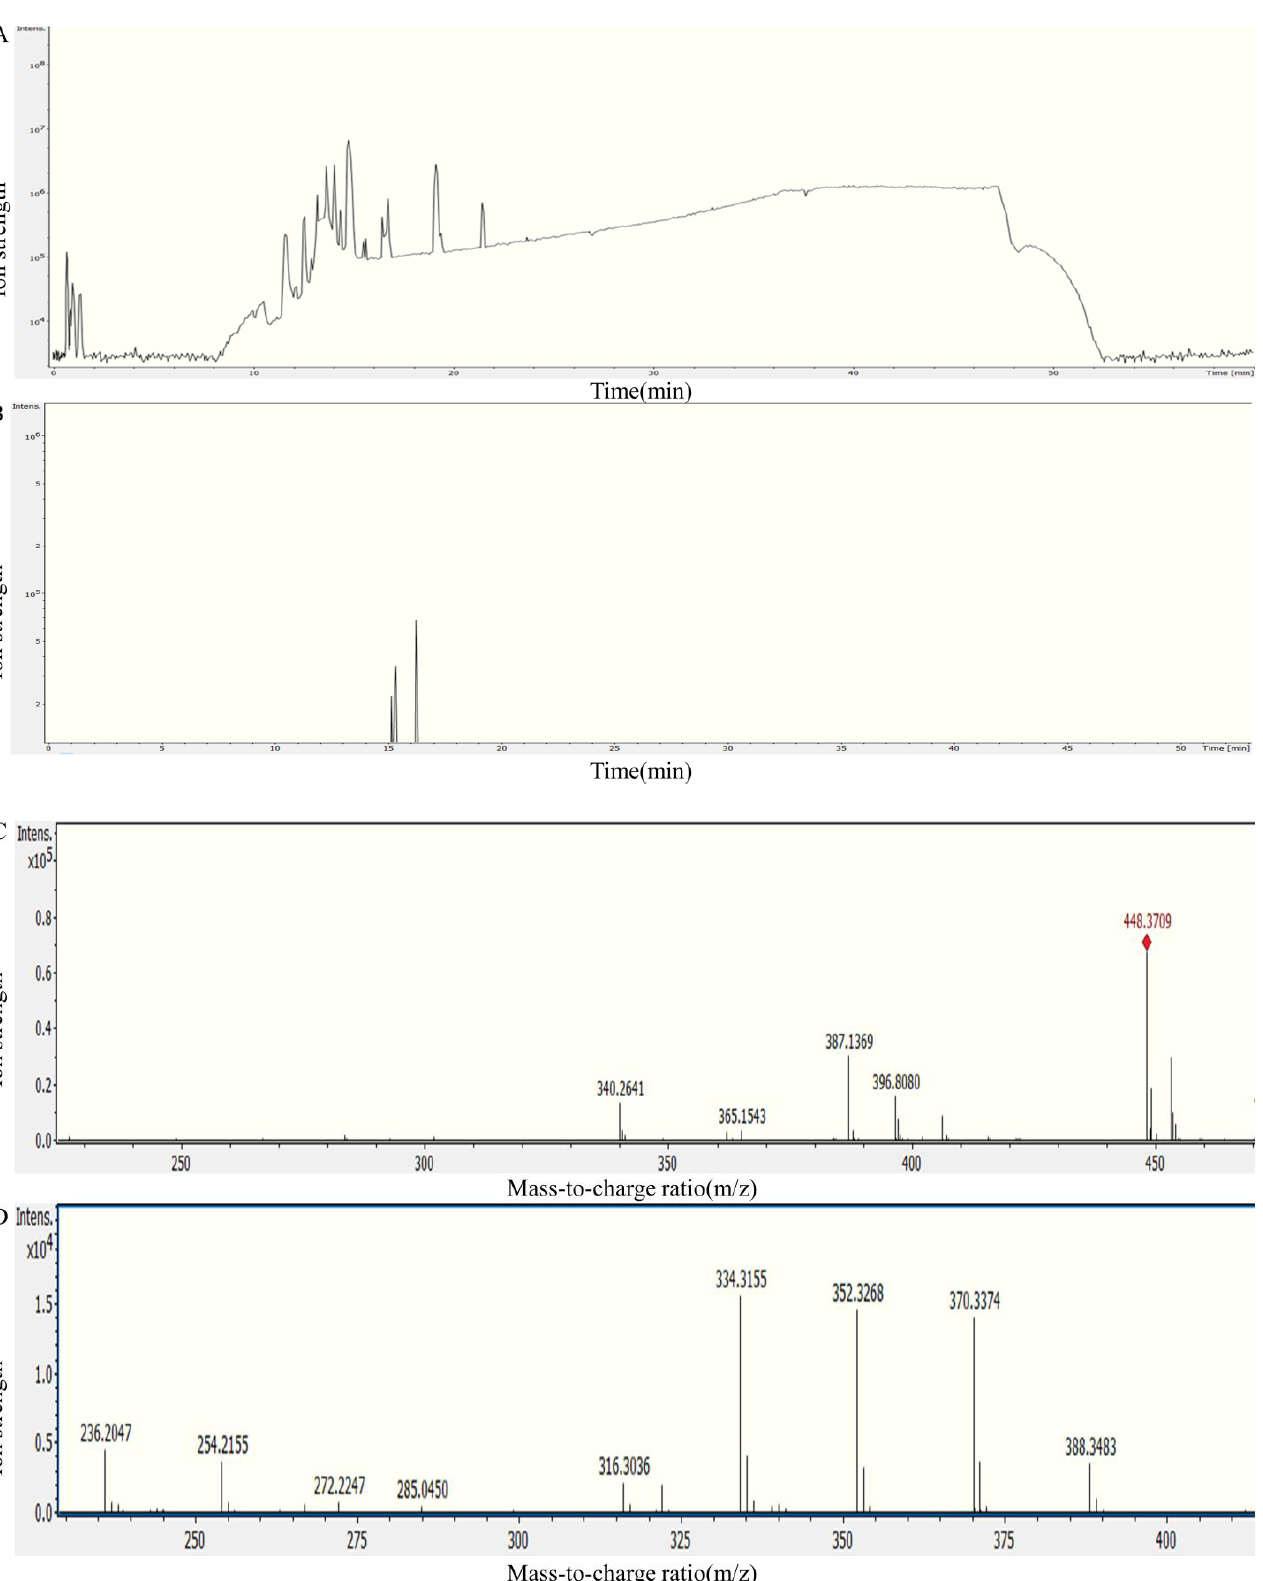
Figure 10. Analysis of FumUPTA degradation of HFB1 by mass spectrometry. ( A ) Total ion flow diagram; ( B ) The EIC chart of 2-acetamide-HFB1; ( C ) The primary mass spectrum of 2-acetamide-HFB1; ( D ) The secondary mass spectrum of 2-acetamide-HFB1 .